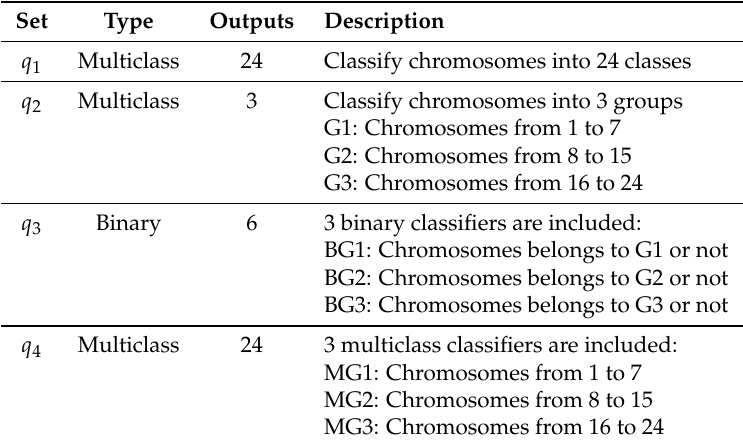
Table 4. Subset of architectures { q 1 , q 2 , q 3 , q 4 } ⊆ Q